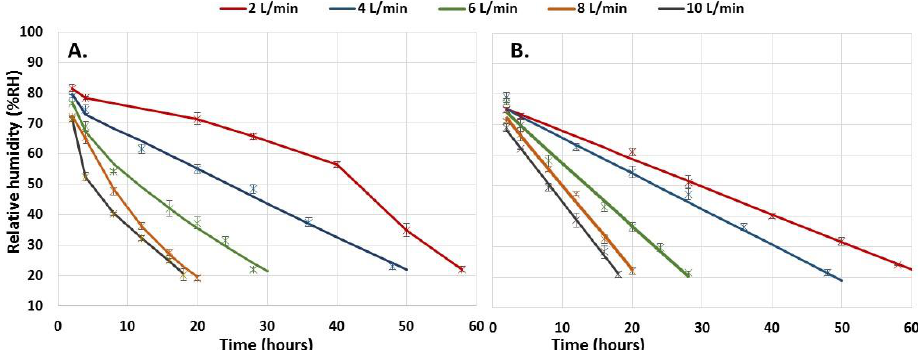
Figure 6. Dehydration profiles of immobilized biomass in calcium alginate capsules. ( A ) . Mycelium, ( B ) . Spores. Error bars represent the standard deviation of two determinations.